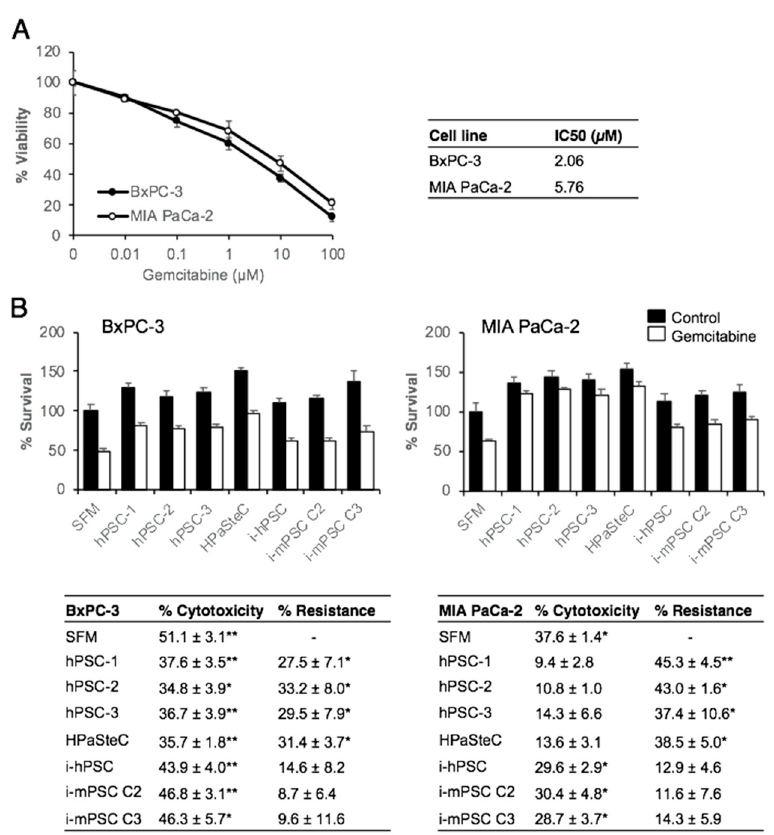
Figure 5. Effect of PSC-CM on chemosensitivity for gemcitabine of pancreatic cancer cells. ( A ) Gemcitabine dose response curves: BxPC-3 and MIA PaCa-2 cells (3000 cells/well) seeded on 96-well plates were incubated with varying concentrations of gemcitabine for 48 h and evaluated for cell viability using the MTT assay. IC 50 values for gemcitabine were calculated using GraphPad Prism 4.0 software. ( B ) BxPC-3 and MIA PaCa-2 cells were incubated with PSC-CM for 24 h prior to incubation with gemcitabine (10 µ M) for 48 h. Cell viability was determined using the MTT assay. Data are mean ± SEM of triplicate determinations. The table indicates gemcitabine-induced cytotoxicity in percentage and PSC-CM-induced resistance to gemcitabine, calculated by relative reduction in cytotoxicity between SFM and PSC-CM. * p < 0.05, ** p < 0.01 comparing SFM with PSC-CM. PSC, pancreatic stellate cell; hPSC, human primary PDAC-derived PSC culture; HPaSteC, PSCs from normal human pancreas; i-hPSC, immortalized human PSCs; i-mPSC C2 and C3, immortalized mouse PSCs clone 2 and 3; PSC-CM, PSC-conditioned medium; SFM, serum-free